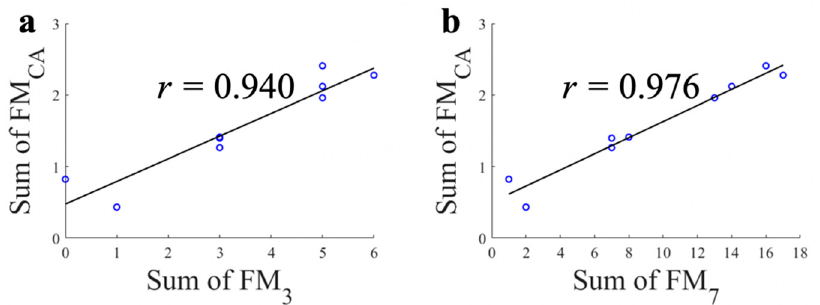
Figure 5. Correlations between the total sum of each FM scale. ( a ) Proposed continuous FM scale (FM CA ) and conventional three point FM scale (FM 3 ); ( b ) Proposed continuous FM scale (FM CA ) and extended seven point FM scale (FM 7 ).